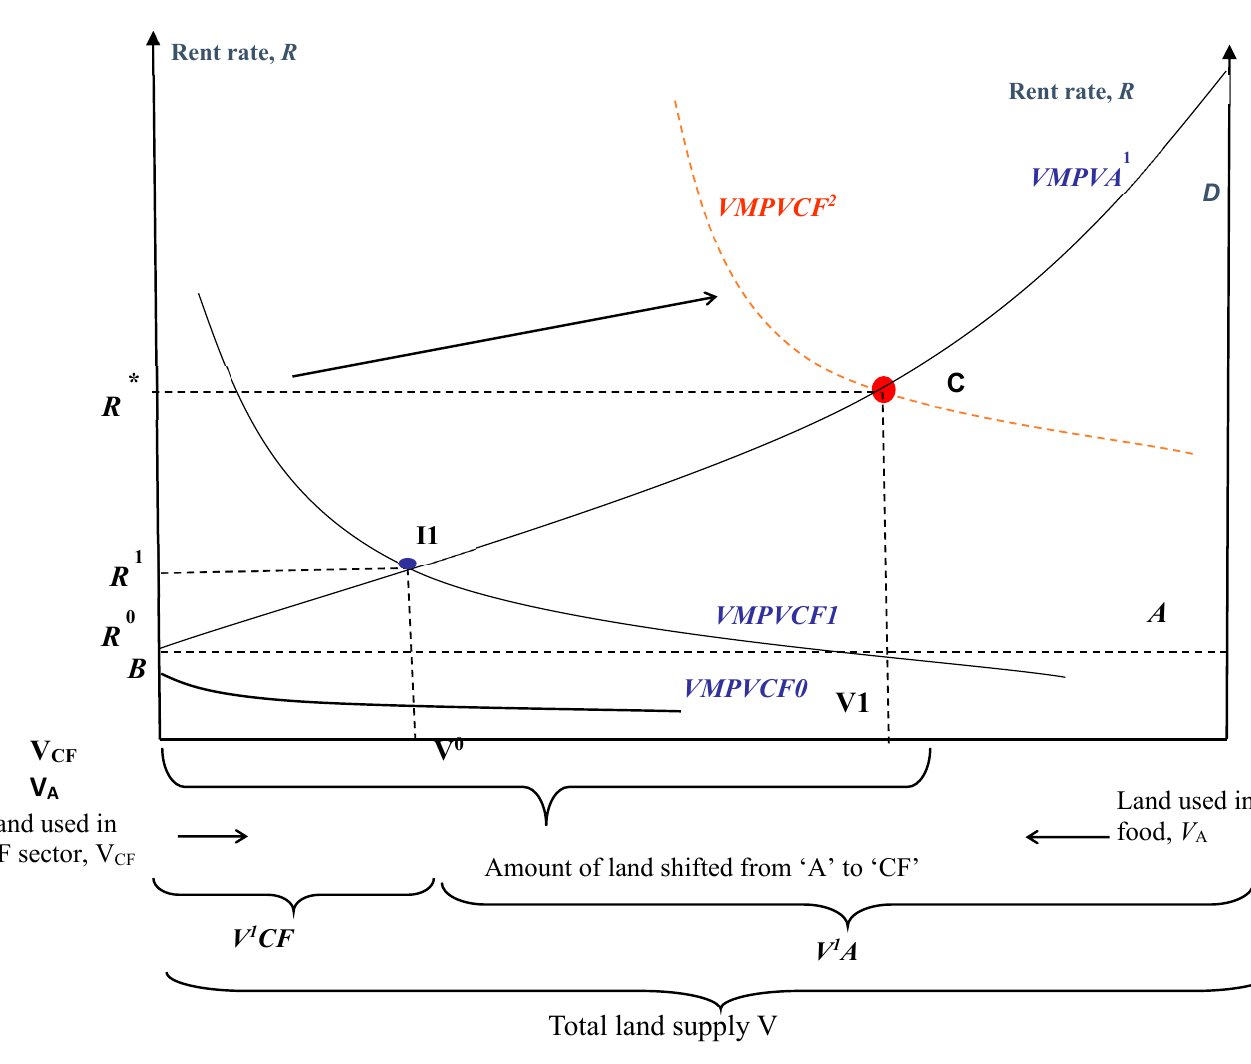
Figure 3. Allocation of land and entry of CF in the agricultural sector. Source: Authors’ Figure 3: Allocation of Land and entry of CF in the Agricultural Sector.